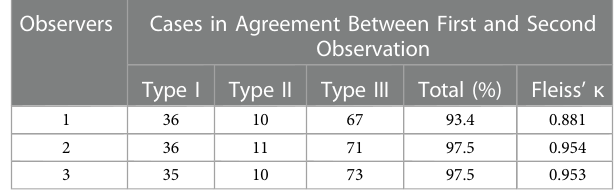
TABLE 4 Clinical evaluations in type III patients (mean±SD).